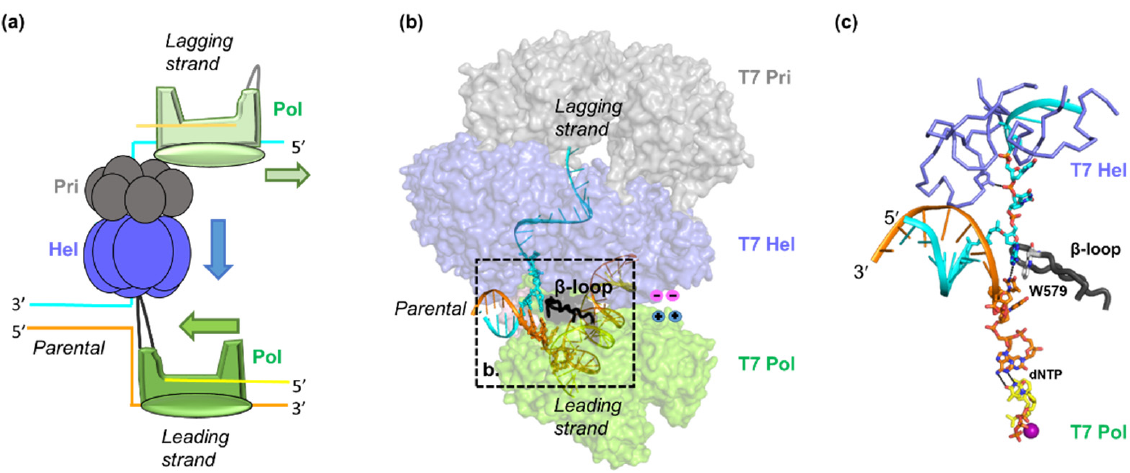
leading-strand and lagging-strand DNA synthesis. ( b ) The Hel–Pol–DNA fork structure. ( c ) A zoom-in view of the DNA